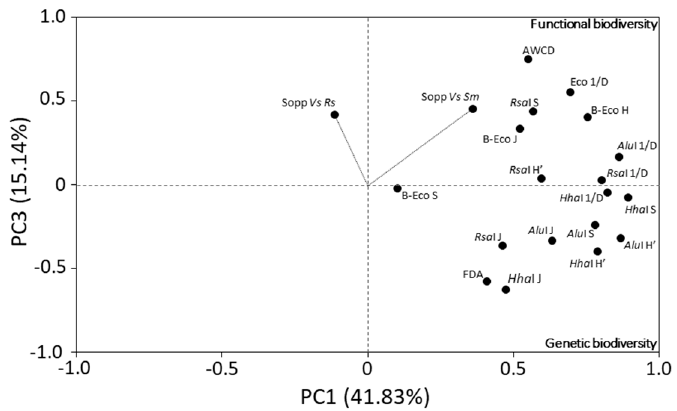
Figure 6. Biplot distribution of descriptive, Richness (S), Shannon (H ′ ), Evenness (J ′ ), and Simpson (1/D) diversity indexes, calculated on T-RFLPs produced with Alu I, Hha I, Rsa I restriction enzymes and Biolog® EcoPlate™ (B-Eco) community levels of physiological profiles, as revealed by PCA in relation to the suppressive (Sopp) potential of compost microbial communities against the two pathosystems R. Solani ( Vs Rs) and S. minor ( Vs Sm).